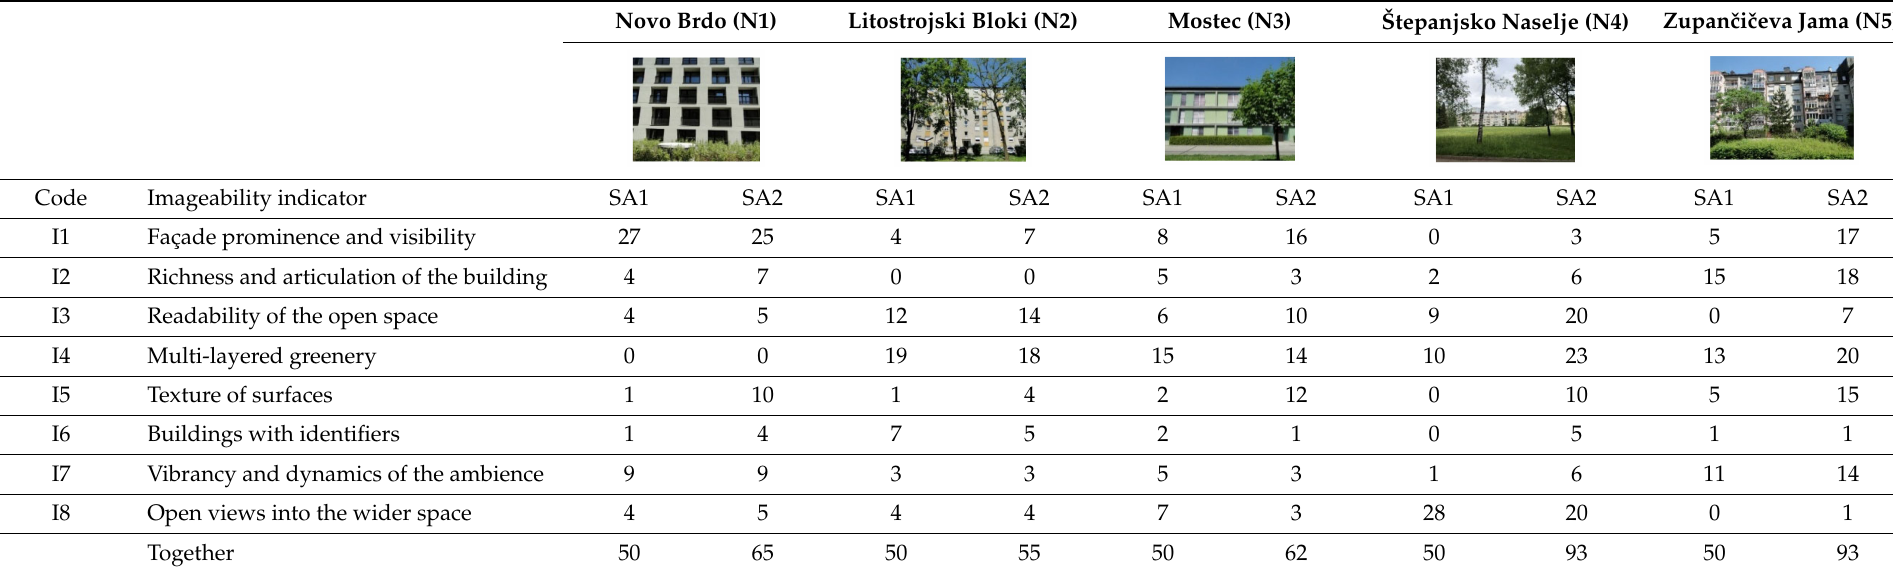
Table 1. Number of responses to perception of imageability according to the neighborhood and the survey